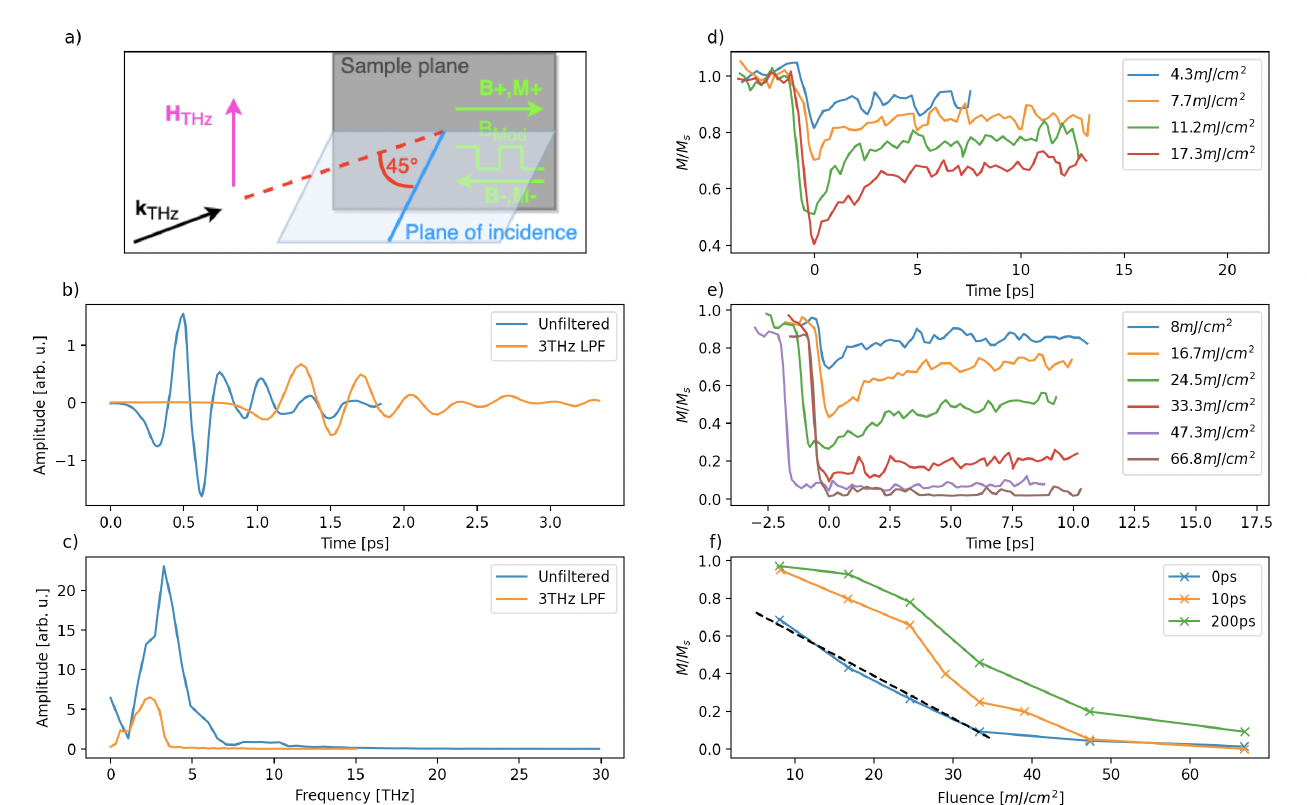
Figure 1. ( a ) The experimental setup for THz pump and optical MOKE probe. ( b ) The triggering unfiltered THz pulse. ( c ) Fourier transform of the unfiltered THz pulse ( d ) Terahertz-induced demagnetization taken with 3 THz low pass filter and THz excitation levels of 4.3, 7.7, 11.2 & 17.3 mJ/cm 2 . ( e ) The demagnetization measurements taken with 6 THz low pass filter for 8, 16.7, 24.5, 29, 33.3, 39, 47.3 & 66.8 mJ/cm 2 . ( f ) The fluence-dependent demagnetization taken with 6 THz low pass filter for delay of 0,10 and 200 ps, with a straight line as a guide for the eye to showcase the near linear